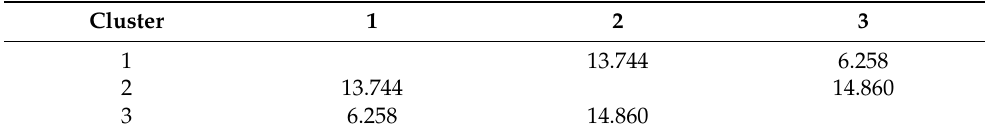
Table 6. Distances between clusters.